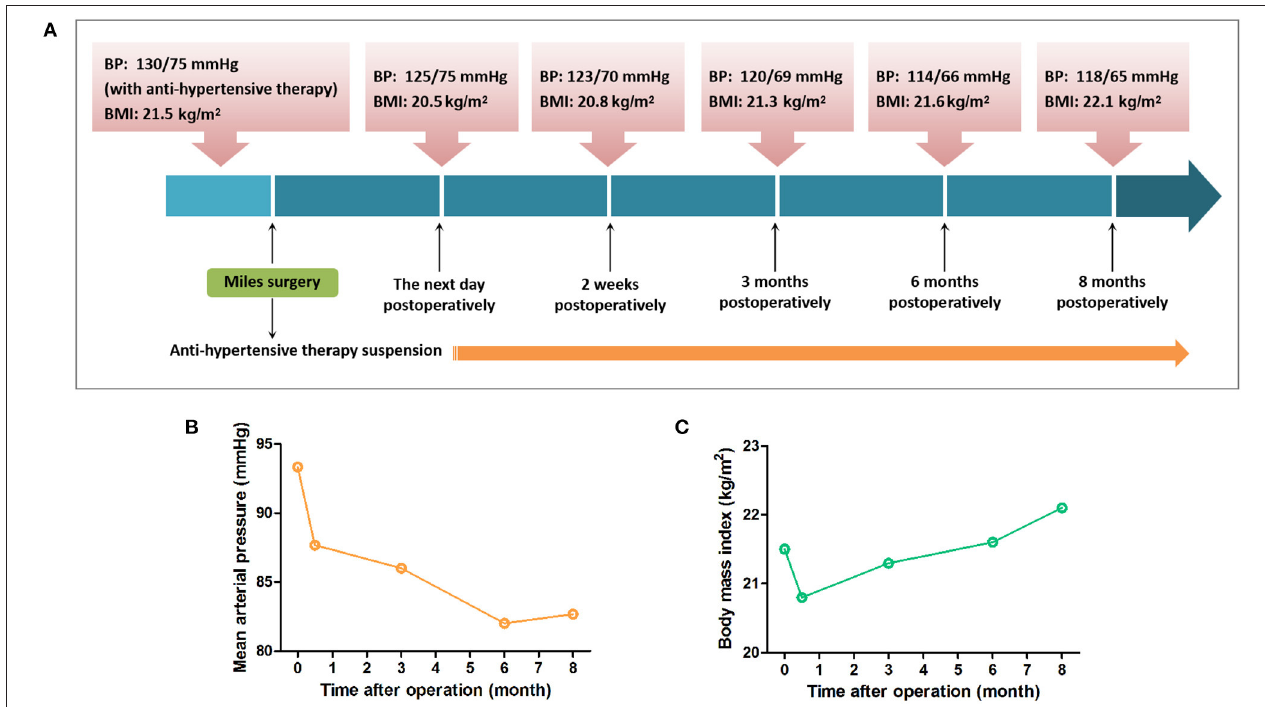
FIGURE 1 | Timeline for blood pressure and BMI of the patient. (A) The blood pressure and BMI of the patient during the follow-up are showcased as a timeline. (B) The blood pressure of the patient indicated as the mean arterial pressure had been maintained normal without anti-hypertensive drug treatment postoperatively. (C) BMI of the patient decreased lower than preoperative level 2 weeks postoperatively and then recovered 3 months after the operation.